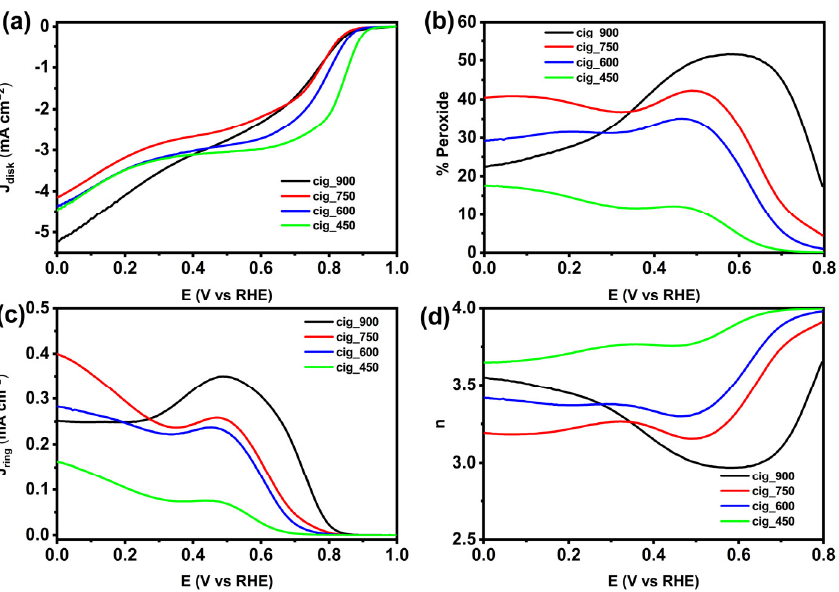
Figure 8. RRDE results of the samples conducted in alkaline media: ( a ) Disk current density (J disk ) and ( c ) Ring current density (J ring ) recorded at 1600 rpm and 5 mV s − 1 , ( b ) % Peroxide yield and ( d ) the number of transferred electrons (n).